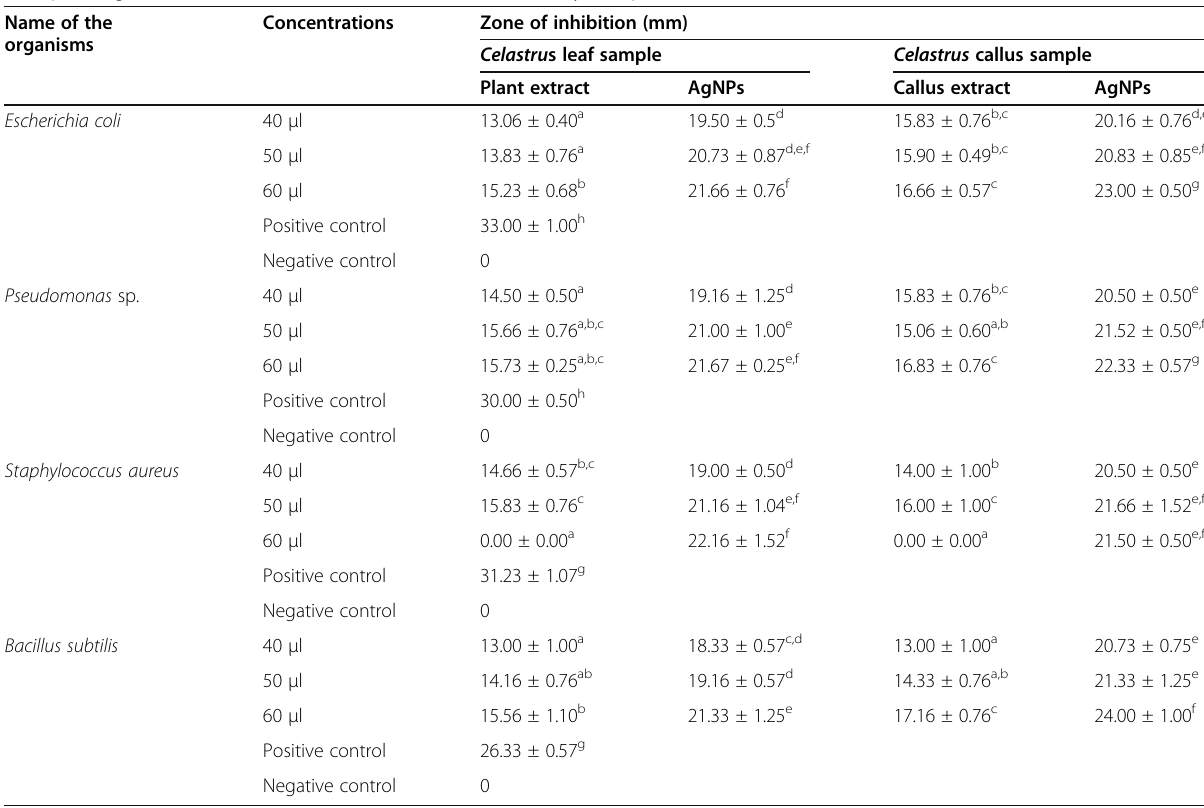
Table 2 Antibacterial activity of silver nanoparticles synthesized by using CP leaf and callus extract against various microorganisms. The data were statistically evaluated through one-way analysis of variance. The data represents mean ± standard deviation. Data for each column in the respective bacteria followed by the different letters (a to h) are significantly different according to Duncan ’ s multiple range test [29] at P < 0.05. These letters (a to h) usually compare the means of different concentrations and the